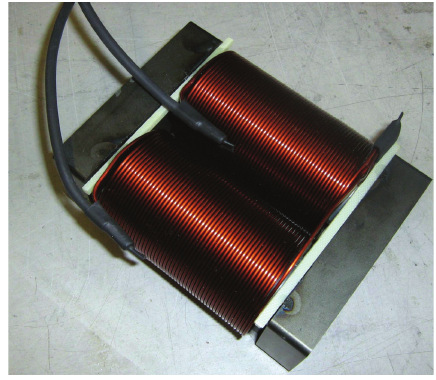
Figure 1: Power inductor with helical flat wire windings.